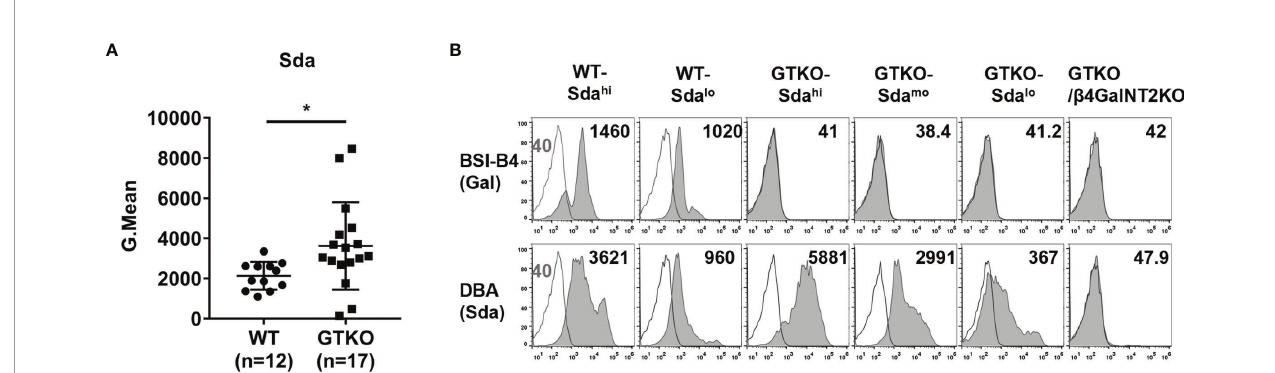
FIGURE 2 | The expression of Sda in WT or GTKO pigs. PBMCs from WT, GTKO, or GTKO/ b 4GalNT2KO pigs were stained for the expression of Gal (by isolectin BSI-B4) and Sda (with Dolichos bi fl orus agglutinin, DBA). The results are reported as geometric mean fl uorescence (Gmean). (A) Comparison of the expression of Sda on WT (n=12) and GTKO (n=17) pig PBMCs. Data are presented as means ± SD (* P <0.05); (B) The expression of Gal and Sda on PBMCs from two wild-type pigs and three GTKO pigs with different levels of Sda expression. White histograms outlined in black represent negative controls that were unstained cells for lectin experiments. The appearance of a single histogram in GTKO or GTKO/ b 4GalNT2KO samples indicates an overlap with the negative